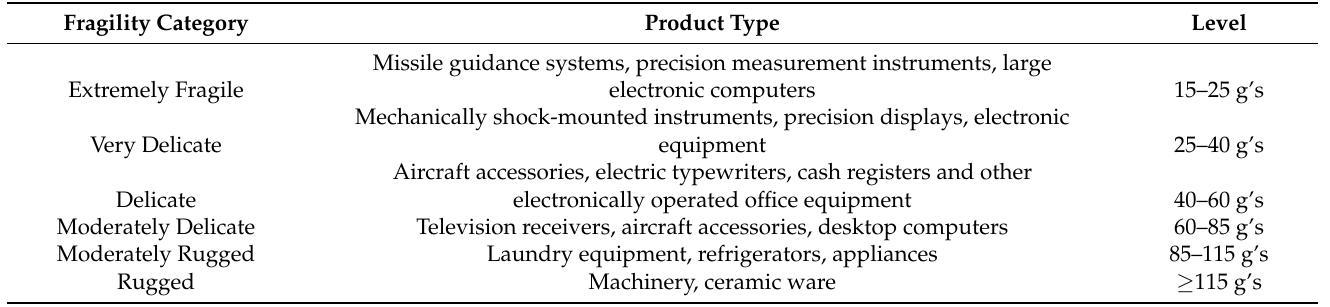
Table 1. Fragility expressed in g’s for different product categories.